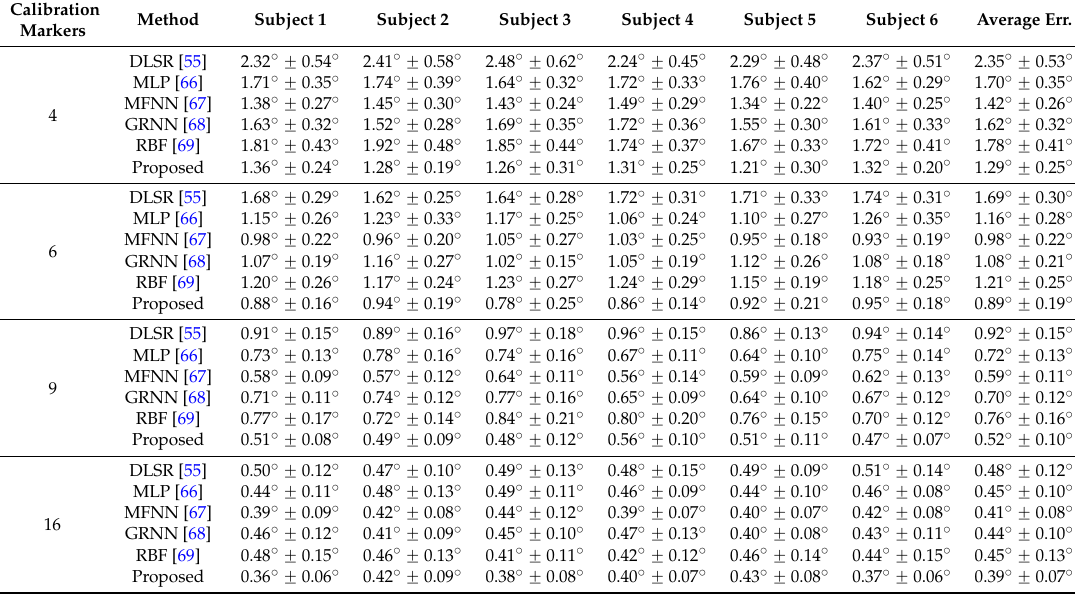
Table A1. Comparison of gaze estimation accuracy between proposed method and other NN methods without considering error compensation.